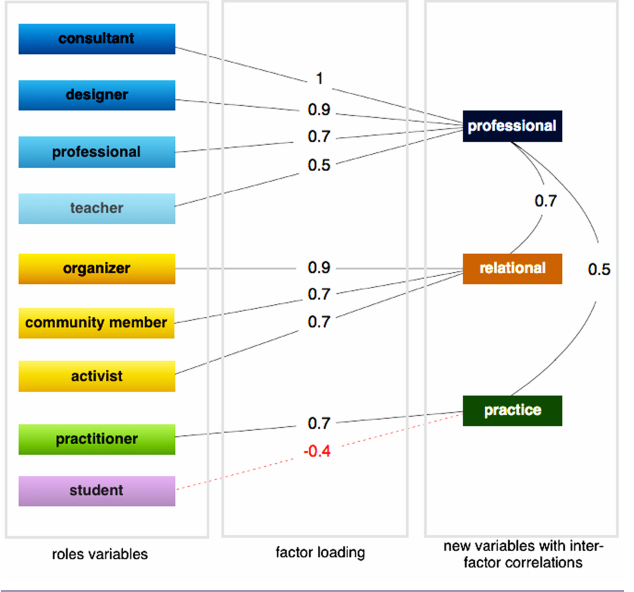
Fig. 3 . Factor structure of nine role variables to three dimensions.